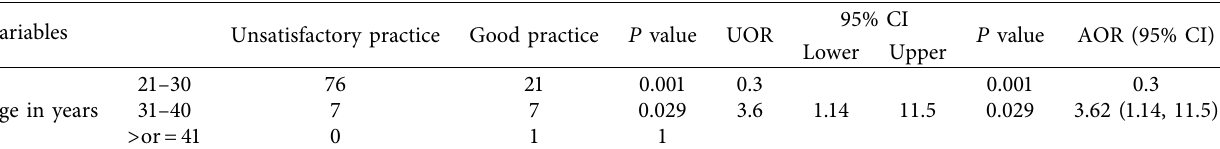
Table 6: Factors associated with nurses’ practice regarding physical restraint use in bivariate and multivariate analysis ( n � 112).